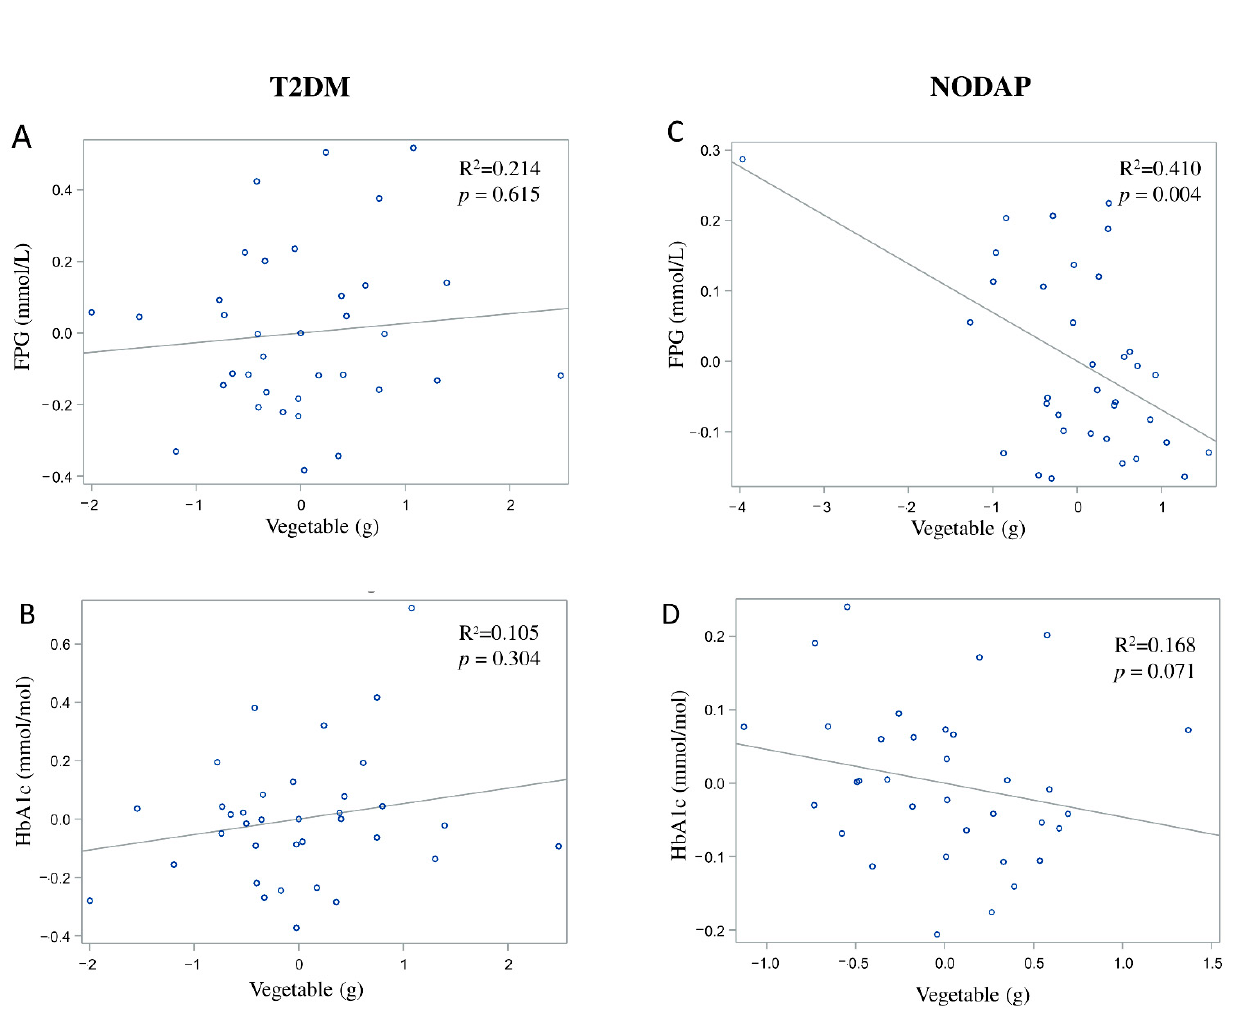
Figure 4. Associations between vegetables intake and markers of glucose metabolism between T2DM ( A , B ) and NODAP group ( C , D ). Abbreviations: T2DM = Type 2 diabetes or prediabetes prior to acute pancreatitis. NODAP = New-onset diabetes or prediabetes after acute pancreatitis. HbA1c = glycated haemoglobin. FPG = fasting plasma glucose. R 2 = adjusted R 2 value (coefficient determinations). Footnotes: FPG, HbA1c, and vegetables were log-transformed. R 2 values were adjusted for age, sex, BMI, energy intake (log-transformed), use of anti-diabetic medications, aetiology of pancreatitis, recurrence of pancreatitis, and presence of pancreatic necrosis.